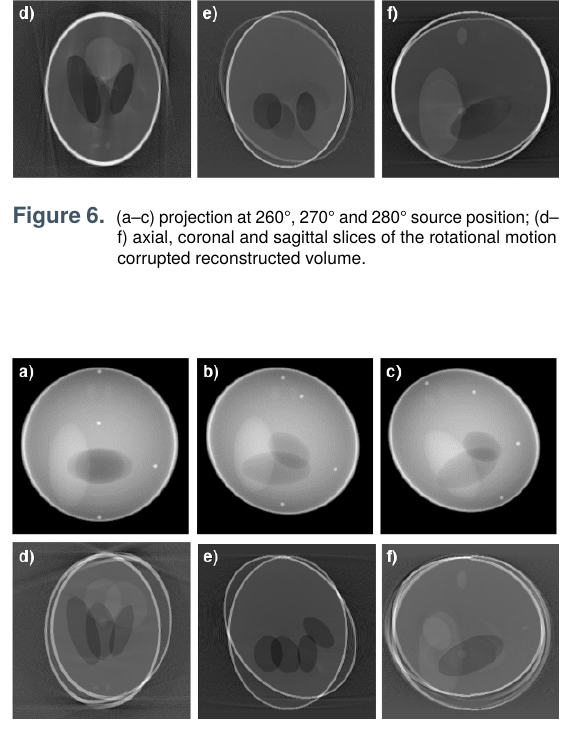
Figure 7. (a–c) projection at 160°, 180° and 200° source position; (d–f) axial, coronal and sagittal slices of the translational and rotational motion corrupted reconstructed